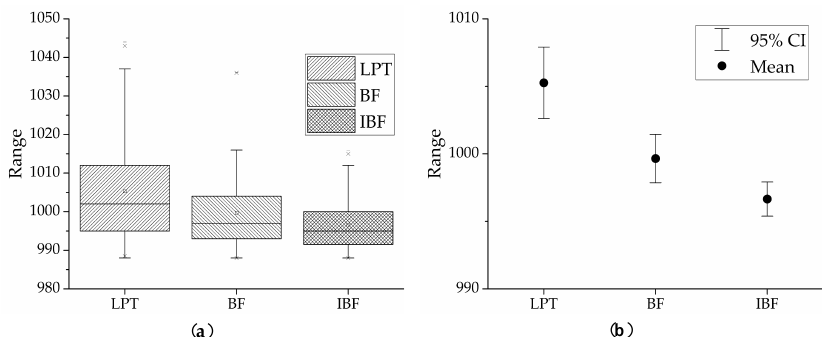
Figure 9. Comparison of LIST, LPT, and IBF algorithms in ( a ) boxplot and ( b ) 95% confidence interval (CI) plot.